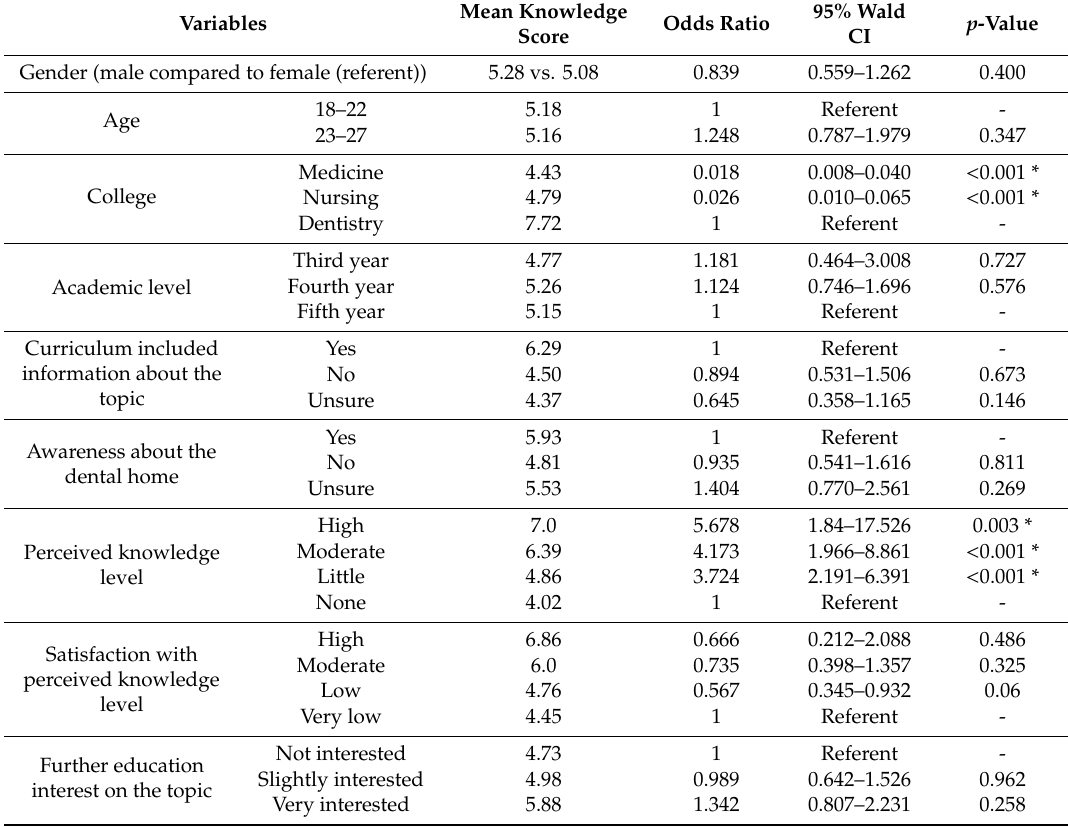
Table 4. Relation of study variables to knowledge